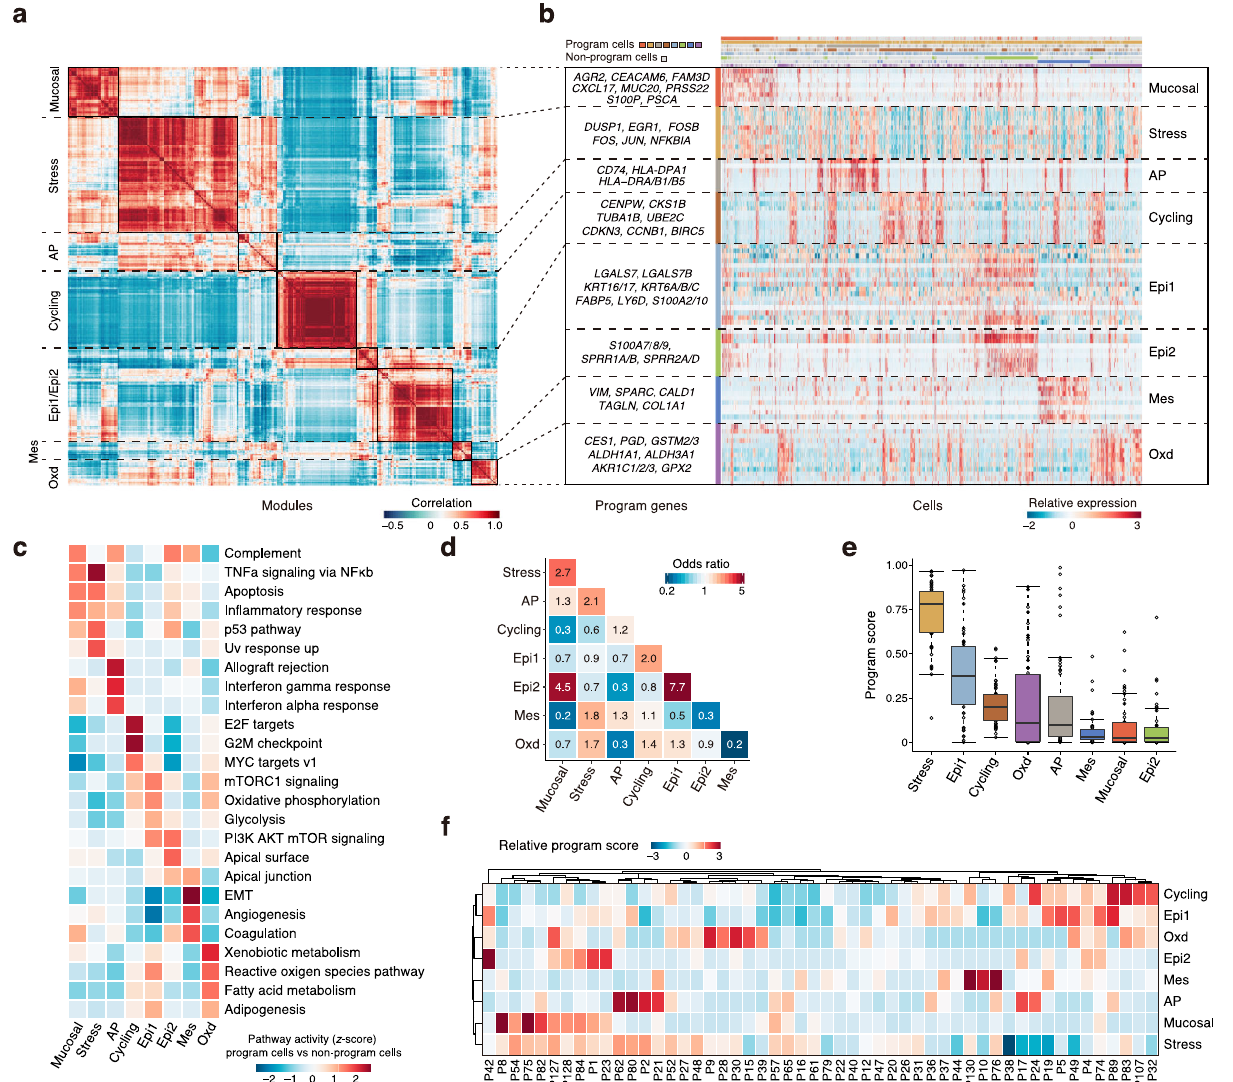
Fig. 3 Identi fi cation of eight common expression programs of epithelial cells in ESCC tumors. a Heatmap showing pairwise correlations of 274 modules derived from 52 tumors. The common expression programs across tumors are aggregated into clusters. b Heatmap showing expression of genes within each program across single cells. Randomly selected 500 cells for each program are shown. Colors above columns correspond to cell state (see Methods). c Heatmap showing differences in pathway activities between program cells and non-program cells for each program scored by GSVA. Each column is normalized by z-score to indicate the relative pathway activities. d Heatmap showing odds ratios assessing for each pair of programs (rows, columns) if they are co-occurrent ( ≥ 2, red) or exclusive ( ≤ 0.5, blue) than expected by chance ( P < 0.05). P values are derived from pairwise Fisher ’ s exact test. e Boxplot showing the proportion of program cells (hereafter refers to as program score) for each tumor ( N = 52) among 8 expression programs, sorted by the median program score. Boxplots show the median (central line), the 25 – 75% interquartile range (IQR) (box limits), the ±1.5 times IQR (Tukey whiskers), and all data points, among which the lowest and the highest points indicate minimal and maximal values, respectively. f Clustered heatmap showing the normalized program scores for all programs in each